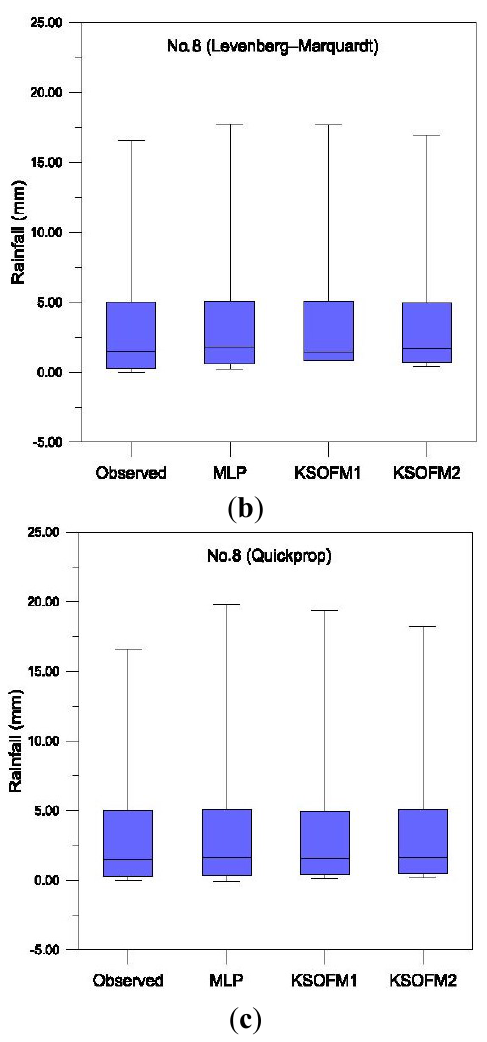
Figure 9. Rainfall box plots for Euiheung (No.8) station (test period). ( a ) Conjugate gradient; ( b ) Levenberg–Marquardt; ( c ) Quickprop.